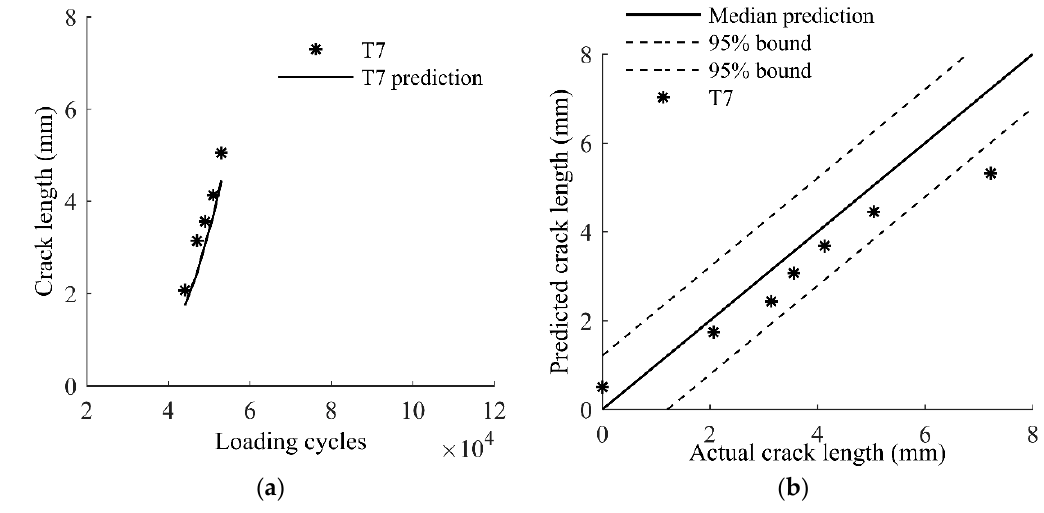
Figure 20. Model predictions and actual measurements of T7: ( a ) crack growth; and ( b ) crack lengths.